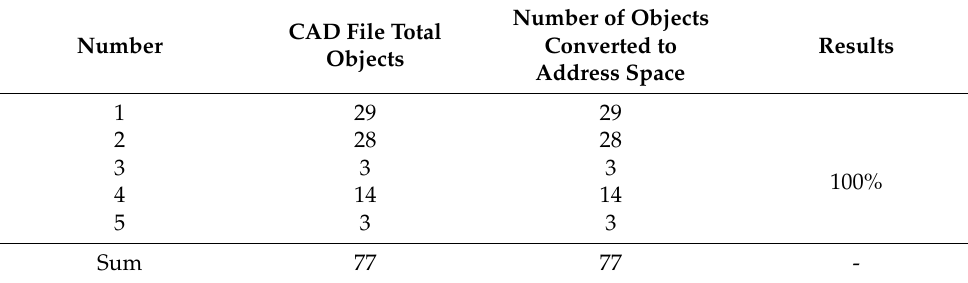
Table 4. Translation accuracy of Address Space in